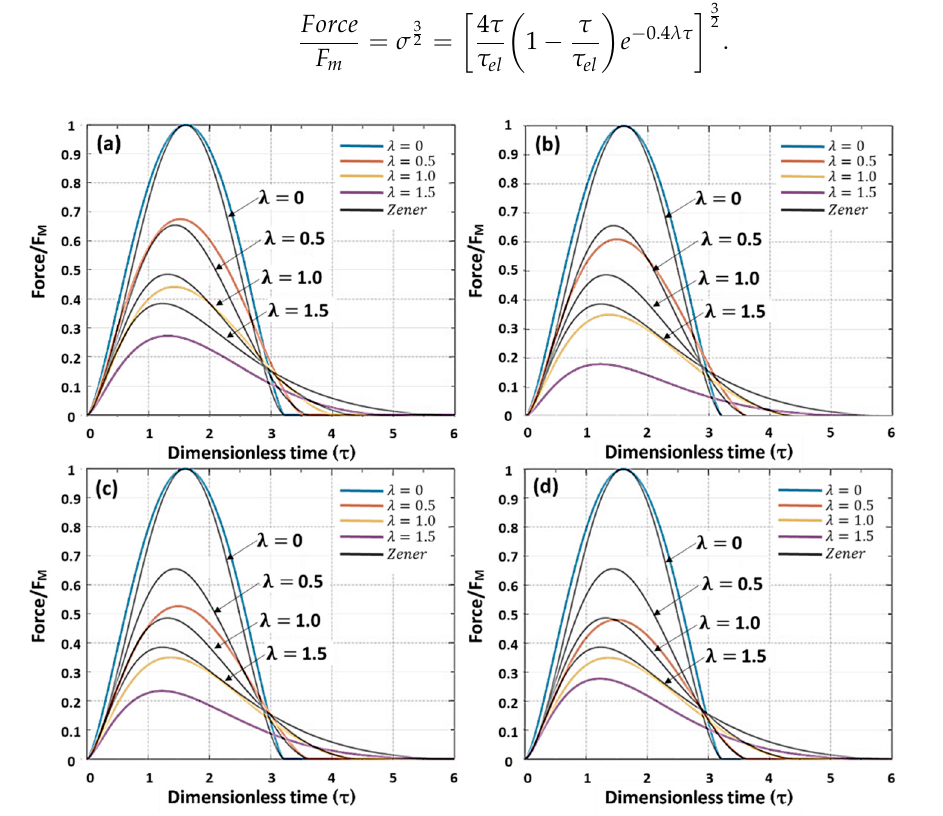
Figure 6. The σ of Equation (30) is multiplied by ( a ) e − λτ and ( b ) e − 0.4 λτ . Figure 6b shows that λ = 0 , and the maximum collision force ( Force/𝐹 (cid:3040) ) is not equal to 1. Therefore, the correction Equation (31), multiplied by in contact time and force of different inelasticity parameters, and the force ( Force/𝐹 (cid:3040) ) of λ = 0 can be corrected to 1, as shown in Figure 7a.